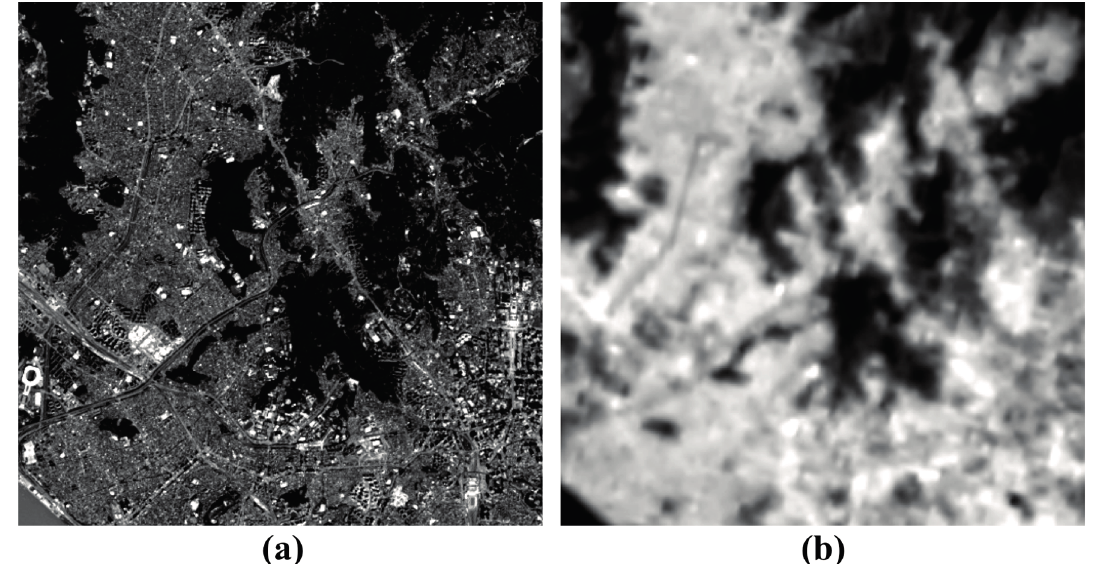
Figure 2. ( a ) PAN and ( b ) TIR images of Landsat 8 used for the fusion